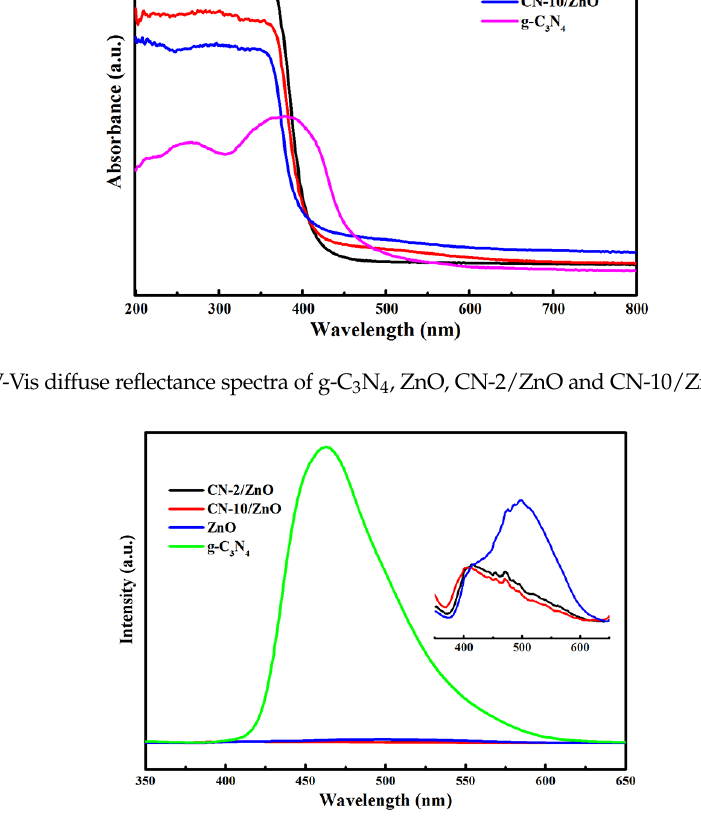
Figure 7. Photoluminescence spectra (PL) spectra of g-C 3 N 4 , ZnO and CN/ZnO photocatalysts. The inset shows the PL spectra of ZnO, CN-2/ZnO and CN-10/ZnO composites.